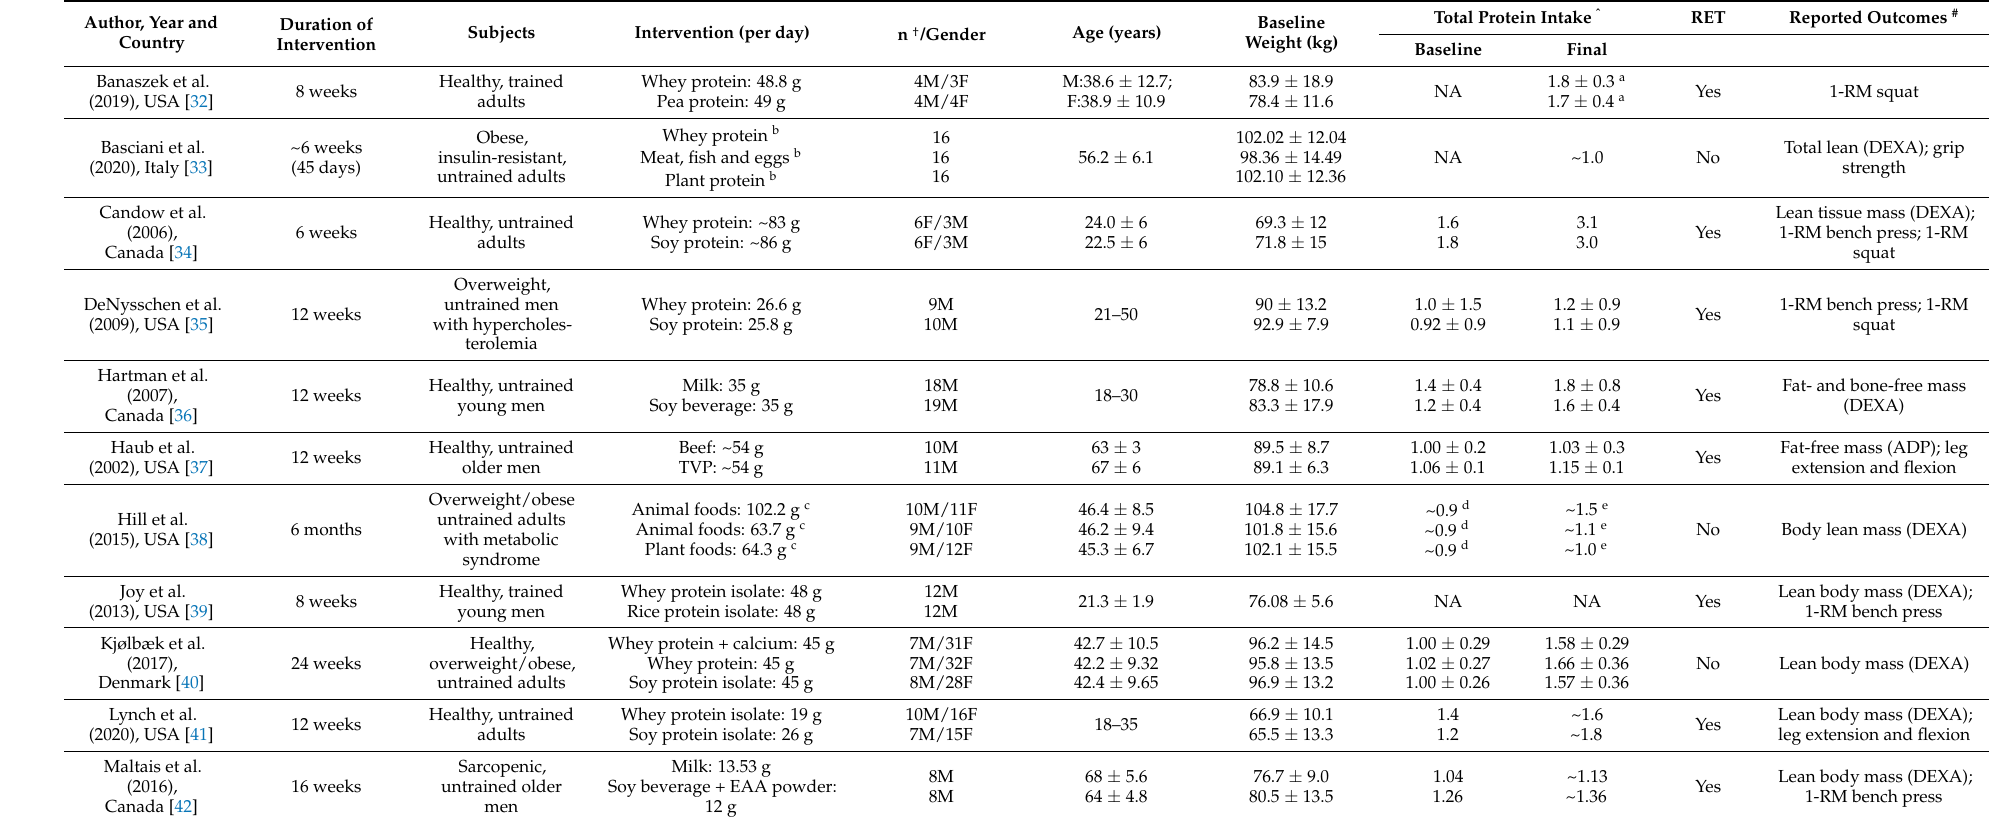
Table 2. Summary of selected studies for systematic review and